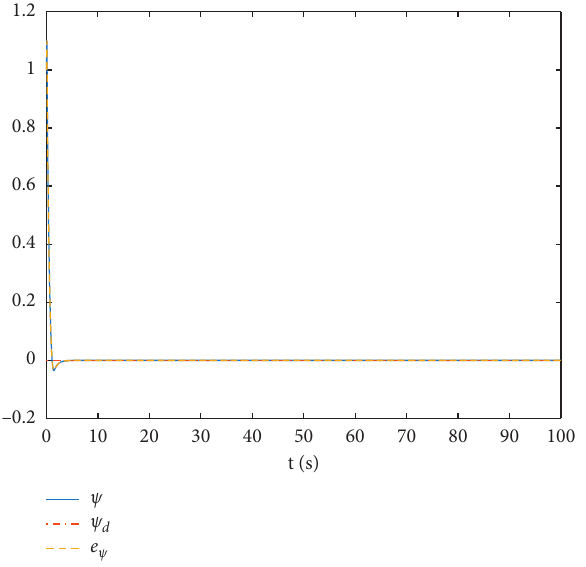
e . Figure 9: Trajectories of neural d , and error ψ